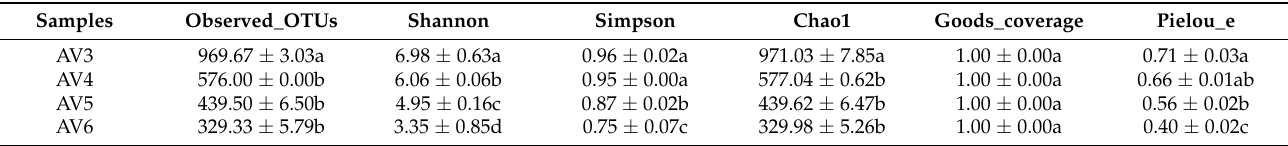
Table 4. Alpha diversity indices of the fungal community in A. villosum rhizosphere soils and a fallow